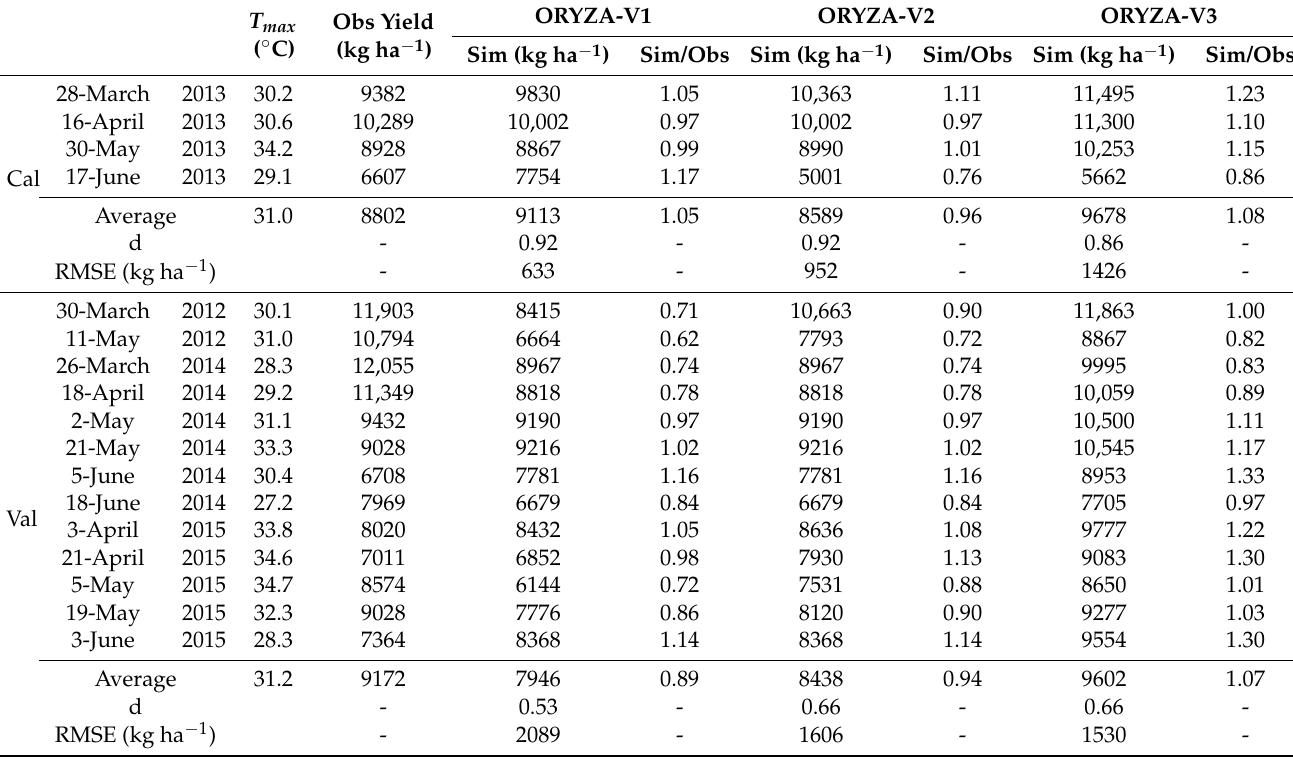
Table 4. Comparison of observed (Obs) and simulated (Sim) rice yield for the Wells cultivar from three versions of ORYZA from field data at Stuttgart, Arkansas, under varying planting dates from 2012 to 2015. Calibration (Cal) results for 2013 were shown (with values in Table S2) along with evaluation (Val) results for 2012, 2014, and 2015. The ratio of simulated to observed yield (Sim/Obs) was indicated along with Wilmott’s index of agreement and RMSE. Average maximum daily air temperature during flowering periods was shown as T max